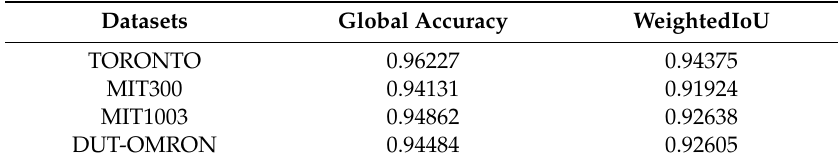
Table 5. Model predication results (i.e., global accuracy) for several datasets (TORONTO, MIT300, MIT1003, and